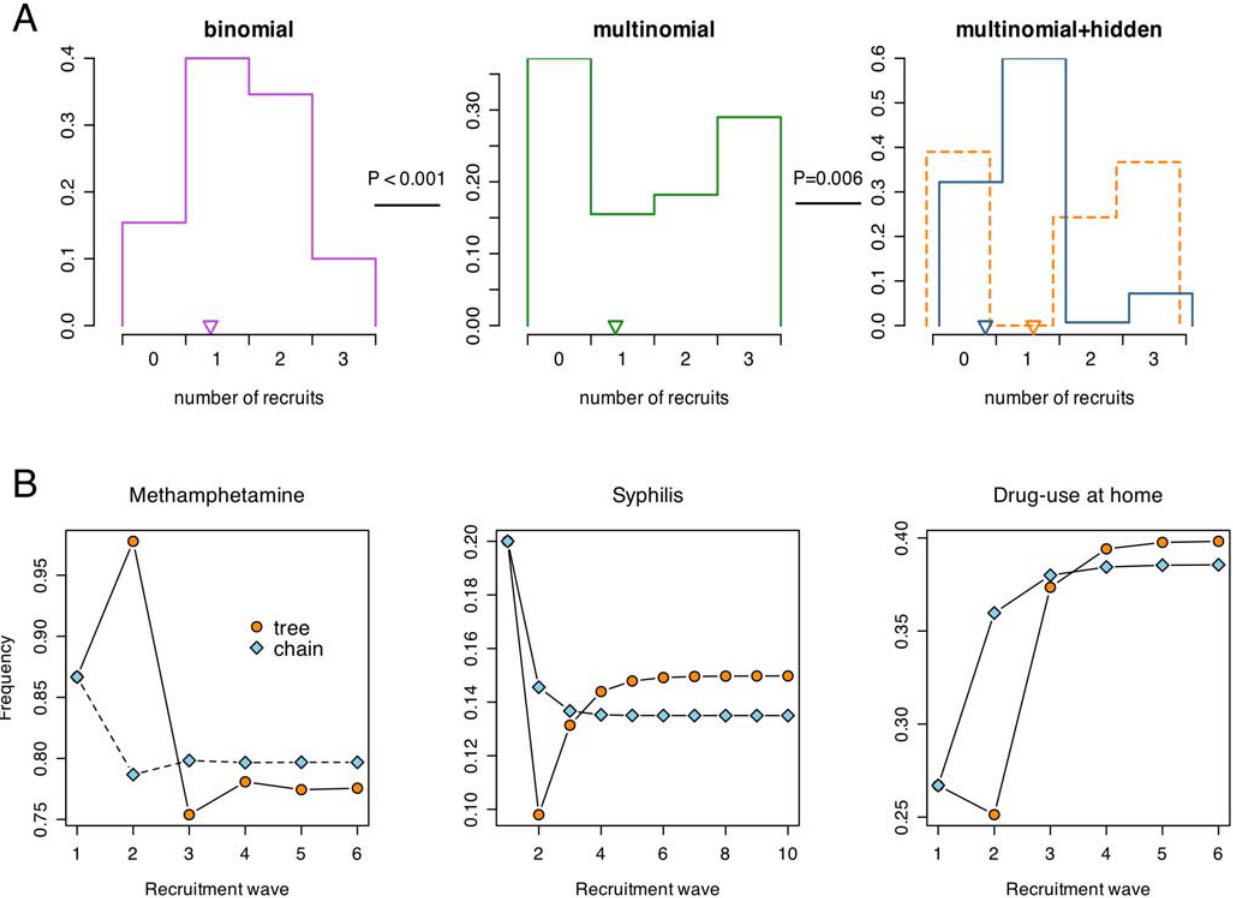
Figure 3. Contrasting model predictions of variation in recruitment dynamics. ( A ) Histograms depict the inferred probability distribution for the number of recruits per respondent under the corresponding model. The dotted line histogram indicates the distribution in recruitment ability for respondents in the same hidden state as seed individuals. The mean number of recruits per respondent is indicated for each distribution by an inverted triangle along the x-axis. Plots are separated by P -values obtained from likelihood ratio tests between adjacent models (always favoring the right-hand side). ( B ) Contrasting projected composition of samples based on Markov chain and multitype branching process (tree) models of RDS, in which the latter included hidden states to model variation among respondents not explained by the corresponding visible attribute ( viz. , reporting prior use of methamphetamine, syphilis serostatus, and reporting injection drug use at home in the past six months). Frequencies correspond to the proportion of respondents in the ‘positive’ visible state ( i.e. , using methamphetamines, syphilis seropositive, or using drugs at home).